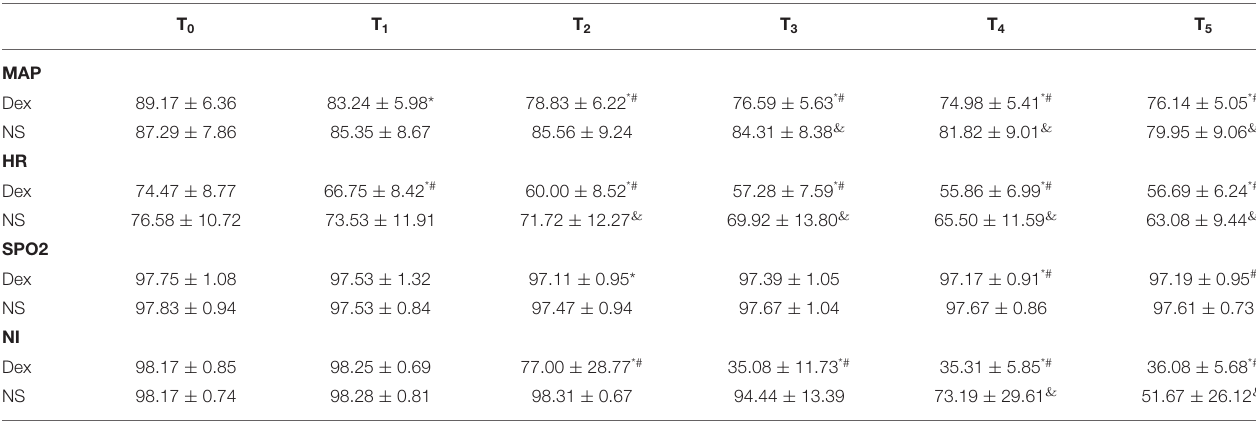
TABLE 3 | Comparison at each time point in two groups ( ¯ x ±